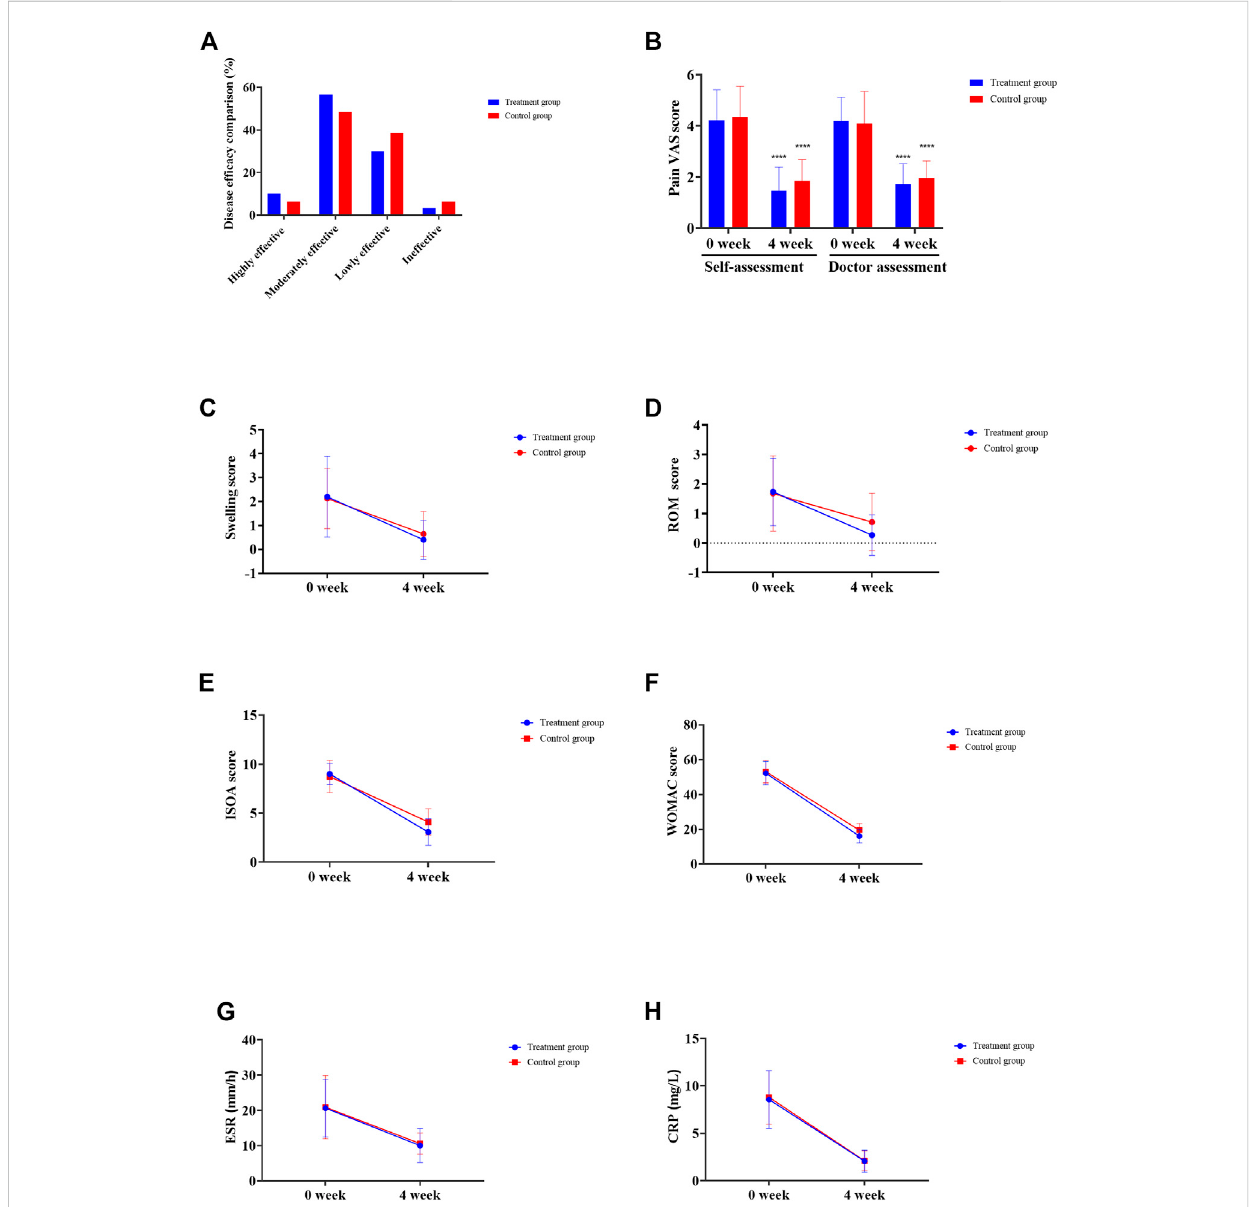
Clinical ef fi cacy assessment. (A) Disease effectiveness comparison. (B) Joint pain VAS score. (C) Joint swelling score. (D) Joint range of motion (ROM) score. (E) Michel Lequesen index of severity for osteoarthritis (ISOA) score. (F) WOMAC score. (G) Erythrocyte sedimentation rate (ESR).